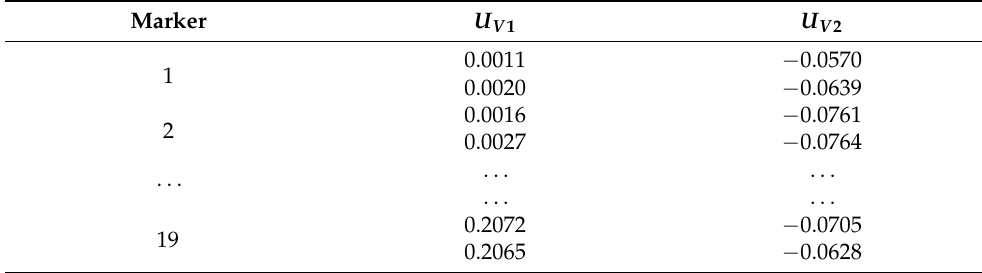
Table 11. Components of the vector U